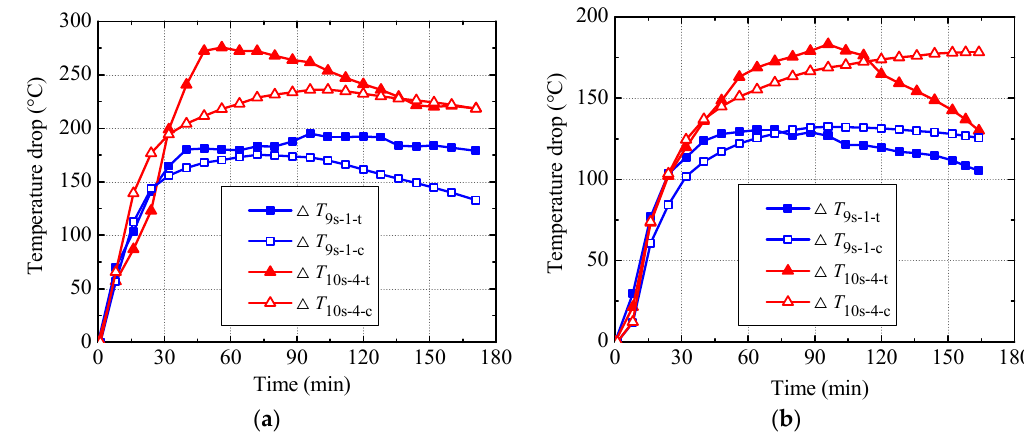
Figure 24. Calculated and measured temperature drop-time curves: ( a ) Specimen B4 and ( b ) Specimen B5. The calculated and measured mid-span deflection-time curves are compared in Figure 25. It can be seen from this figure that the calculated curves generally agree well with the measured ones.